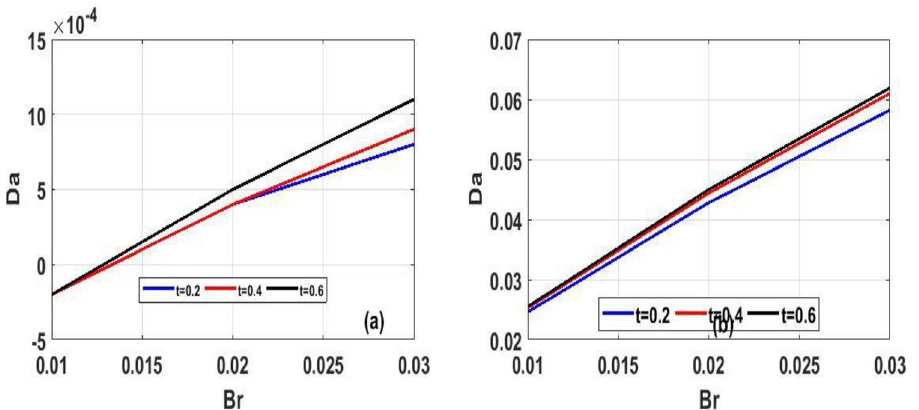
Figure 12. Unsteady skin friction for ( Da ) in proportion to ( t )